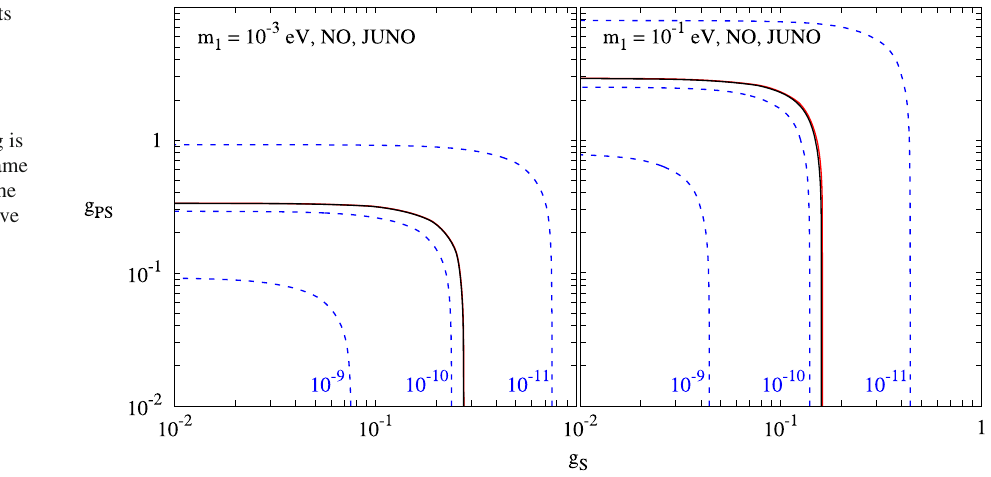
1 . 00 are excluded. In either case, the constraints